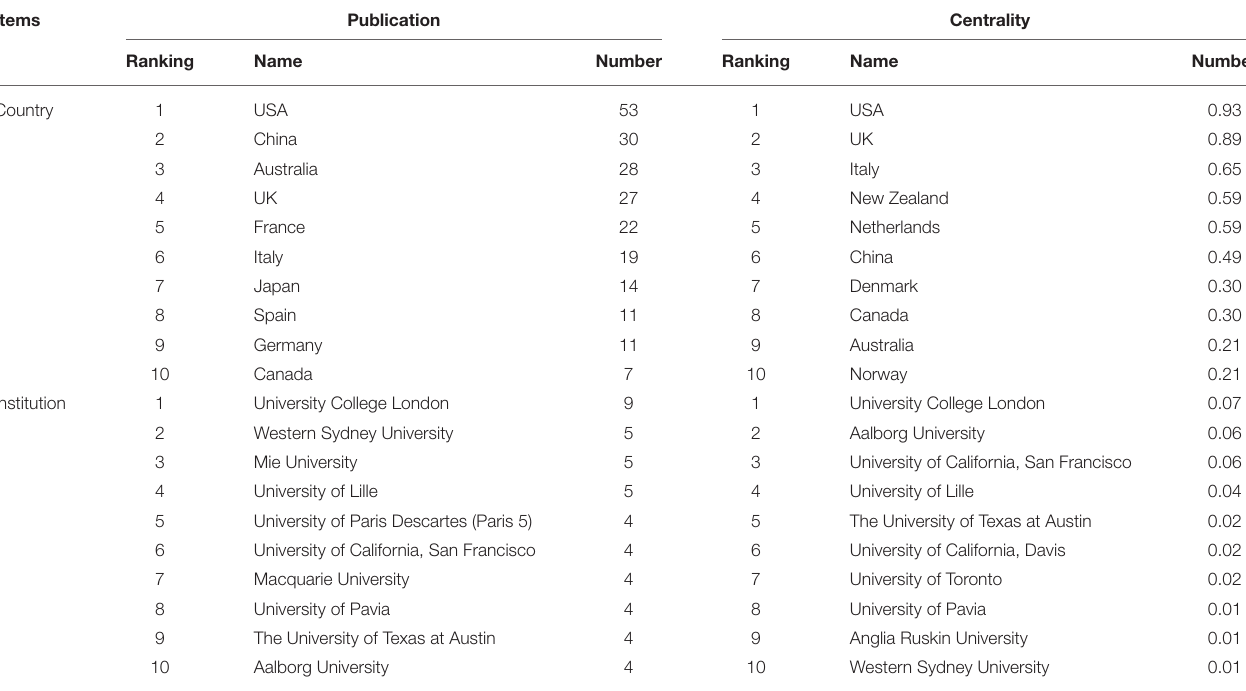
TABLE 1 | Top 10 countries and institutions in terms of number of publications and center value between 2010 and